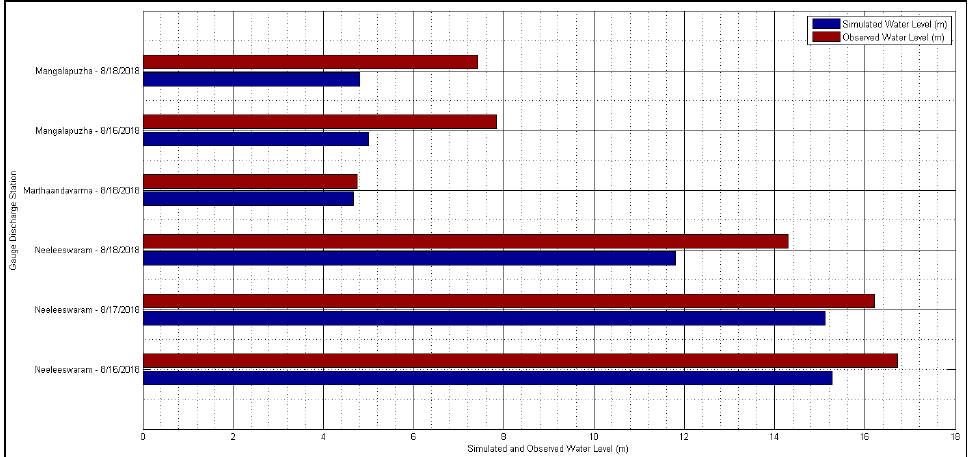
Figure 8. iRIC model calibration at Neeleeswaram (16–18 August 2018), Marthaandavarma (18 August 2018), and Mangalapuzha (16 and 18 August 2018).